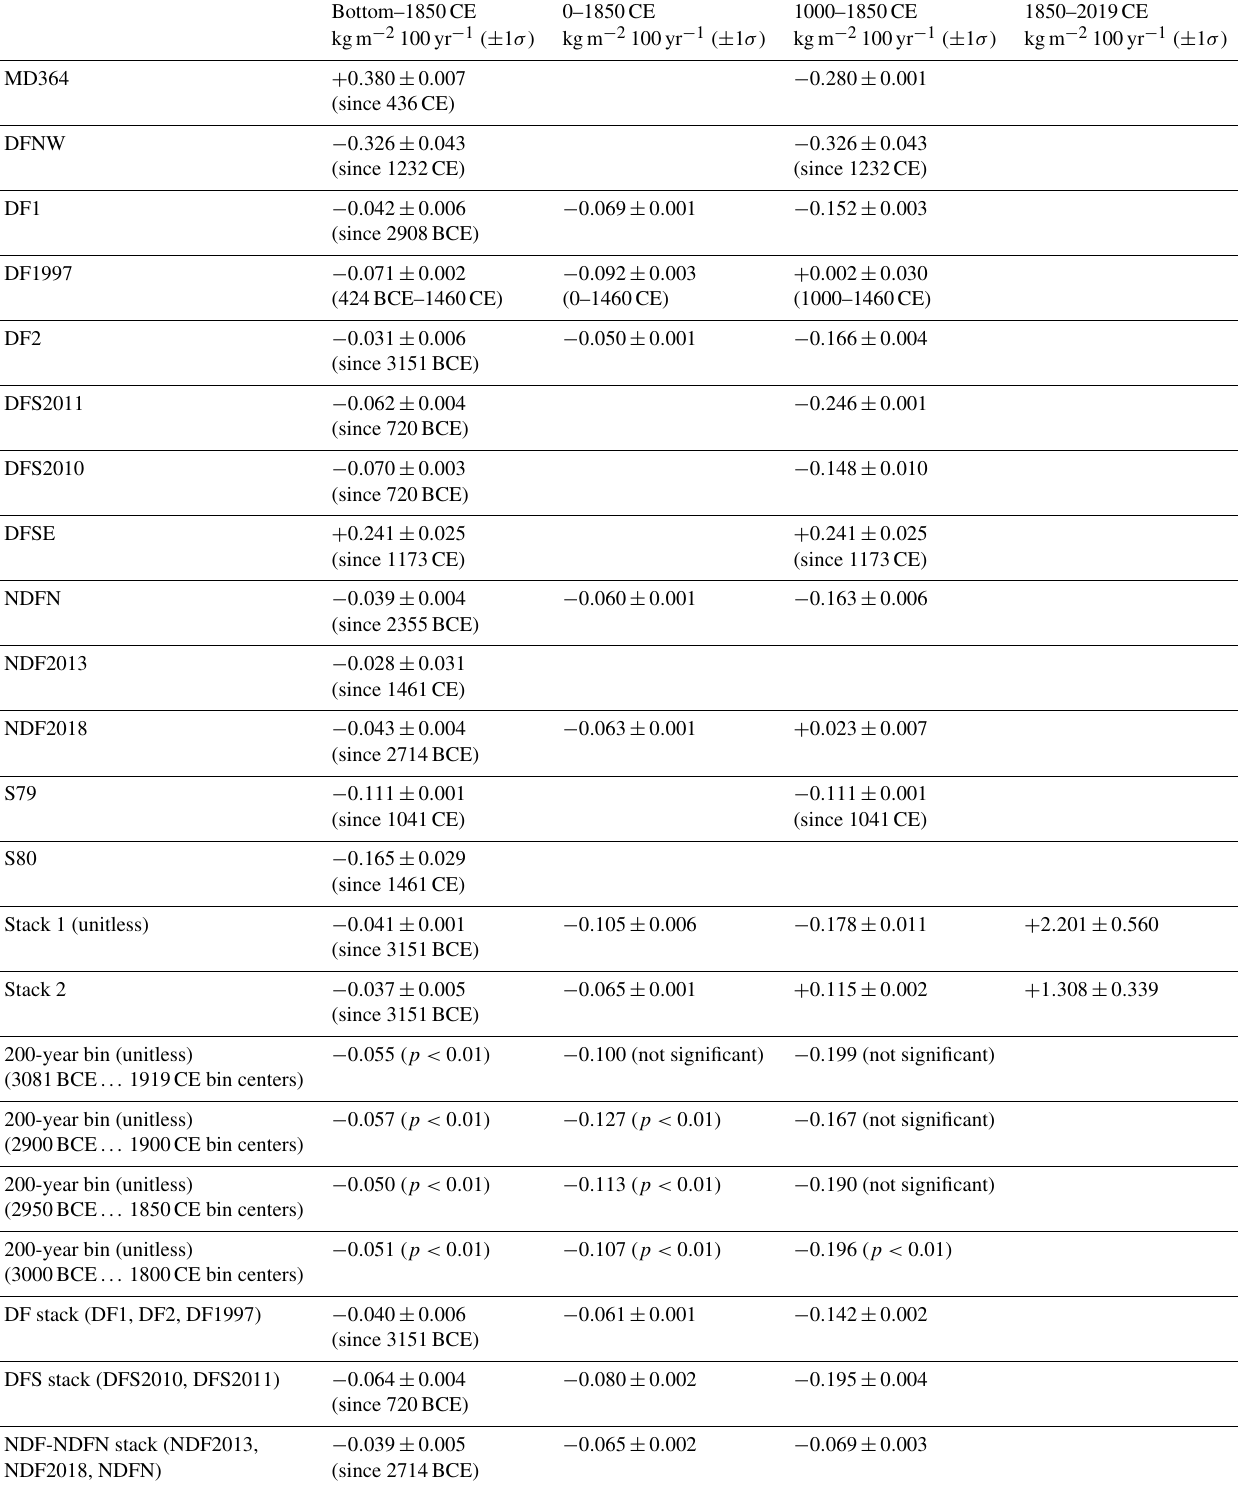
Table 3. Temporal trend of accumulation